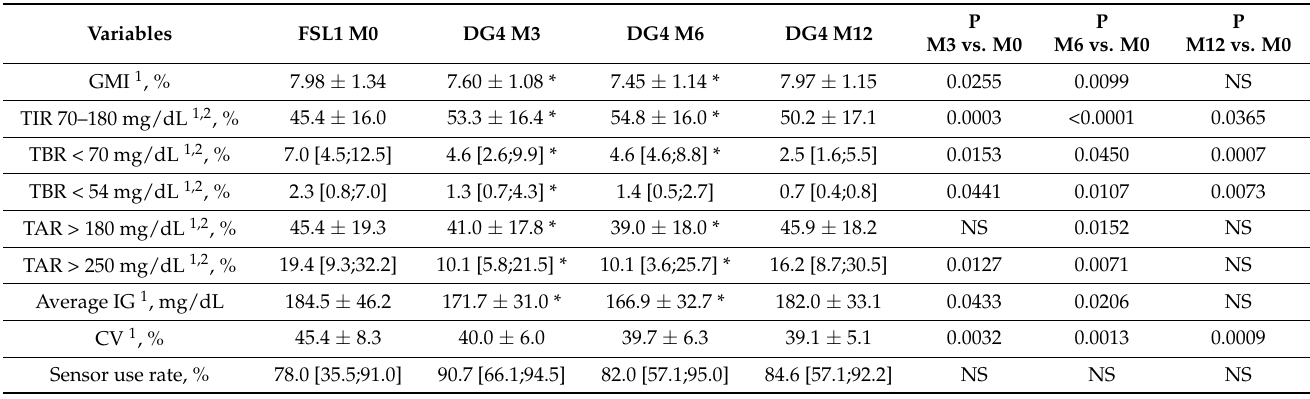
Table 2. Impact of CGM switching from Freestyle Libre1 to Dexcom G4 platinum over 12 months on glucose metrics.